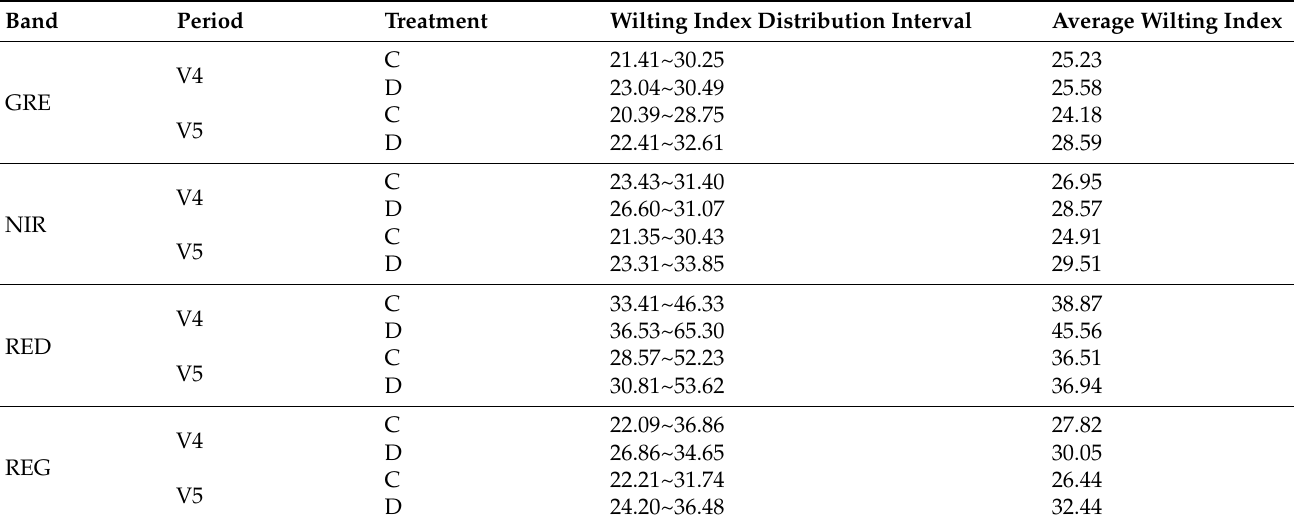
Table 10. Statistical analysis of the soybean canopy wilting